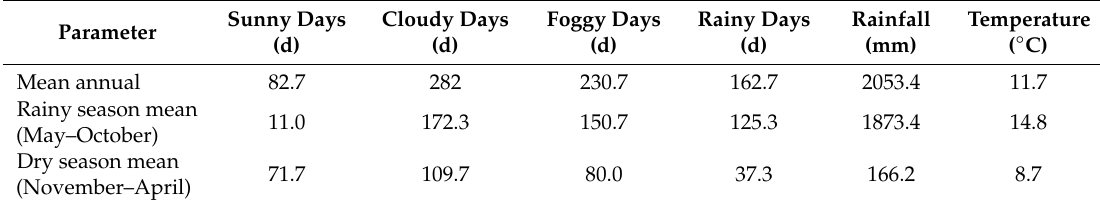
Table 1. The average number of sunny, cloudy, foggy, and rainy days; average rainfall; and average temperature during 2016-2018 in Ailao Mountains, SW